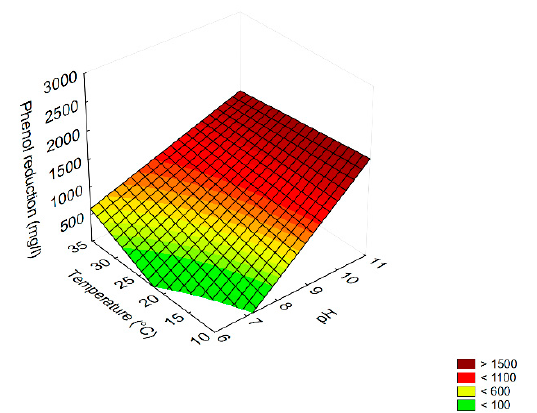
Figure 7. Surface response plot for the interaction temperature / pH on phenol reduction in diluted TOPW by T. harzianum .